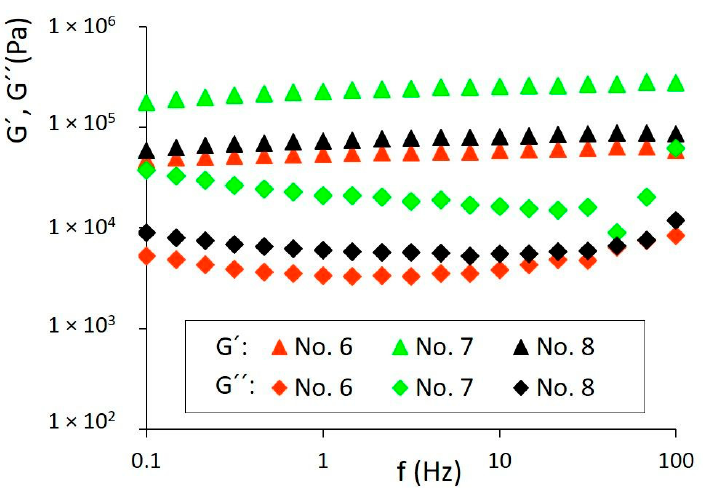
Figure 6. Elastic modulus G ′ (represented by triangles) and viscous modulus G ″ (represented by diamonds) for spreadable fats in the frequency range 0.1–100 Hz on logarithmic scale.